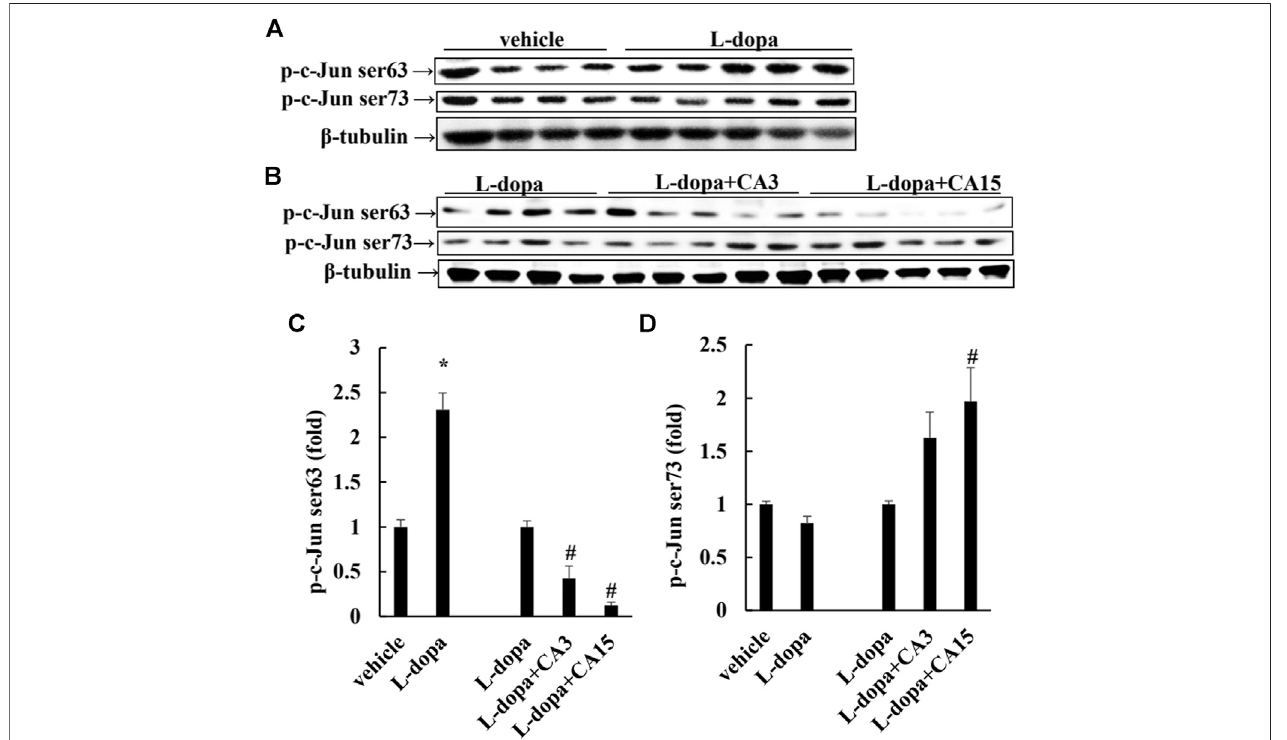
FIGURE 4 | Effect of CA on L -dopa-induced activation of ERK1/2 and c-Jun in 6-OHDA lesioned rats. The phosphorylation of c-Jun Ser63 and c-Jun Ser73 in striatum tissues were determined by Western blotting (A,B) . β -Tubulin was used as the internal control. (C,D) The level of the L -dopa group was set at 1.0. Values are mean ± SEM ( n (cid:1) 3). # p < 0.05 compared with L -dopa-treated